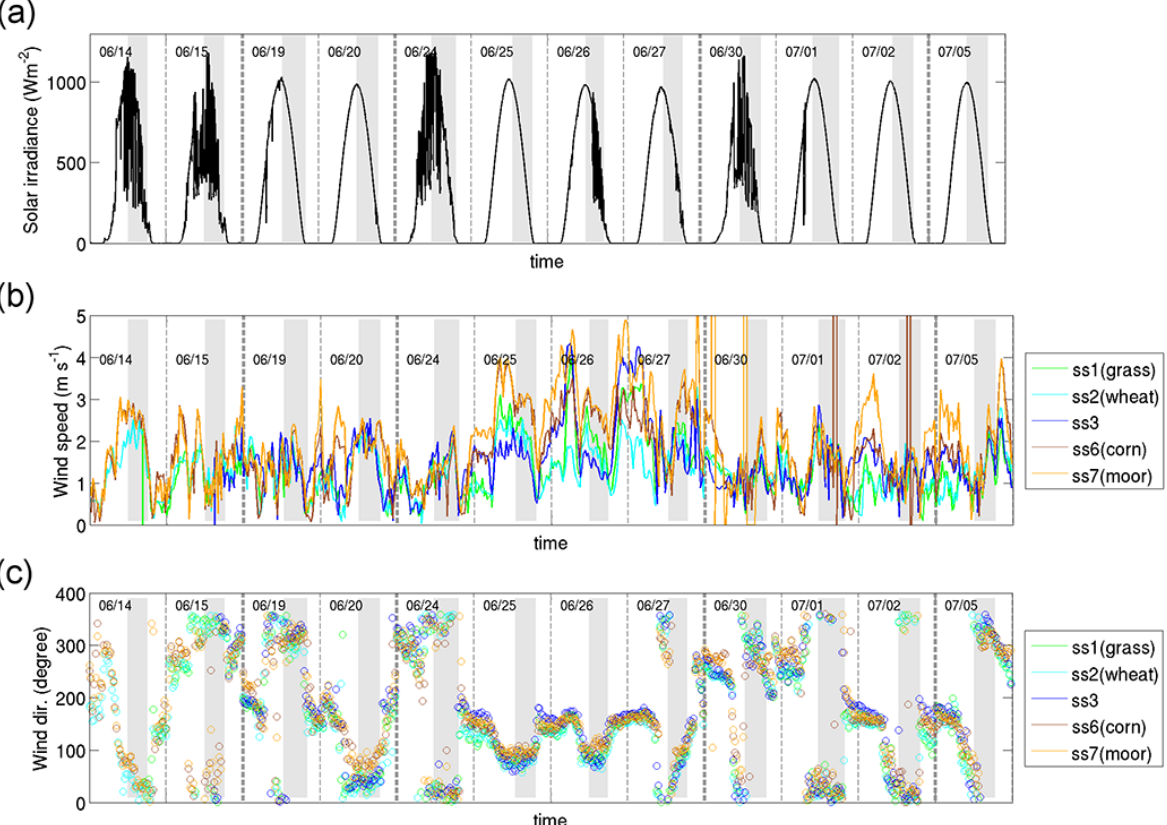
Figure 6. Time series of (a) solar irradiance over the moor surface at site 2, (b) wind speed and (c) wind direction, measured over several surfaces at the different sites (see Fig. 2). The shaded areas mark the AT